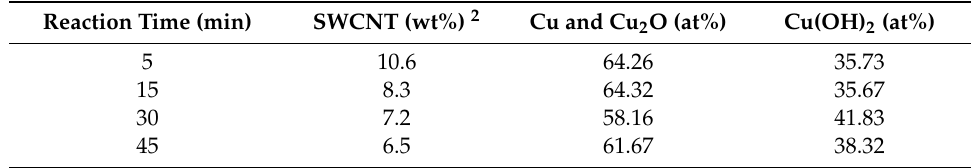
Table 5. Chemical composition of copper species estimated from the relative areas of